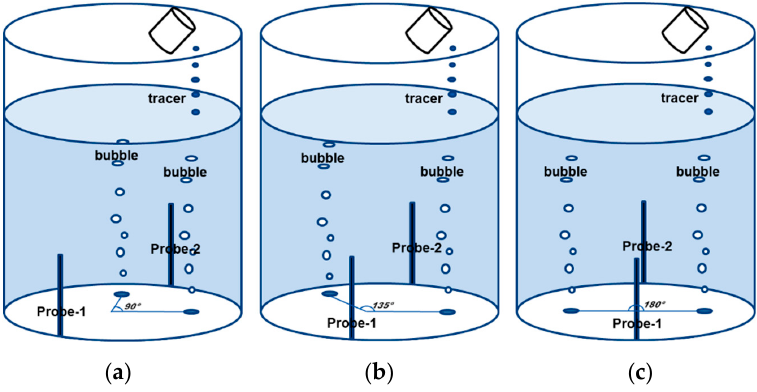
Figure 5. Schematic diagram of the porous plugs and conductivity probes’ configurations at radial angles of ( a ) 90°; ( b ) 135°; and ( c ) 180°.